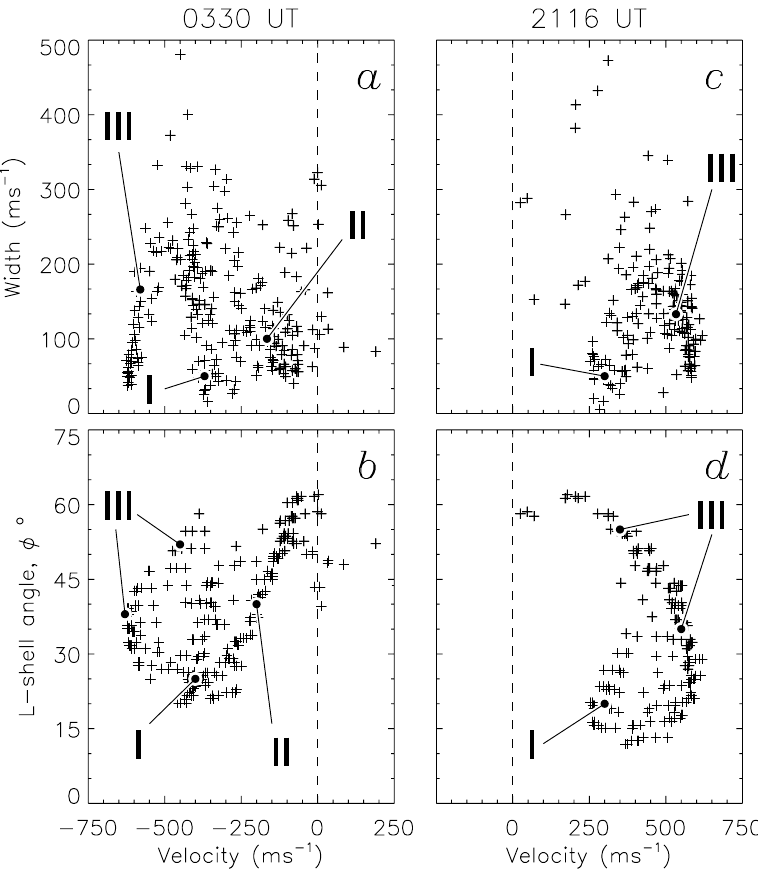
Fig. 1. Scatter plots of (a) and (c) the spectral width and (b) and (d) the L-shell angle versus Doppler velocity for two intervals on 24 February 1997. Also shown are the echo populations I, II, and III identified in a previous study (see text for details).